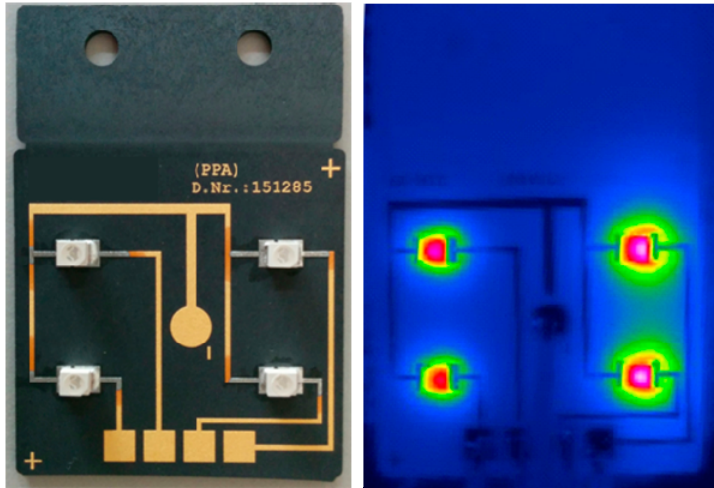
Figure 14. ( Left ): Example of a test specimen equipped with LEDs. ( Right ): Thermal image of the test specimen.